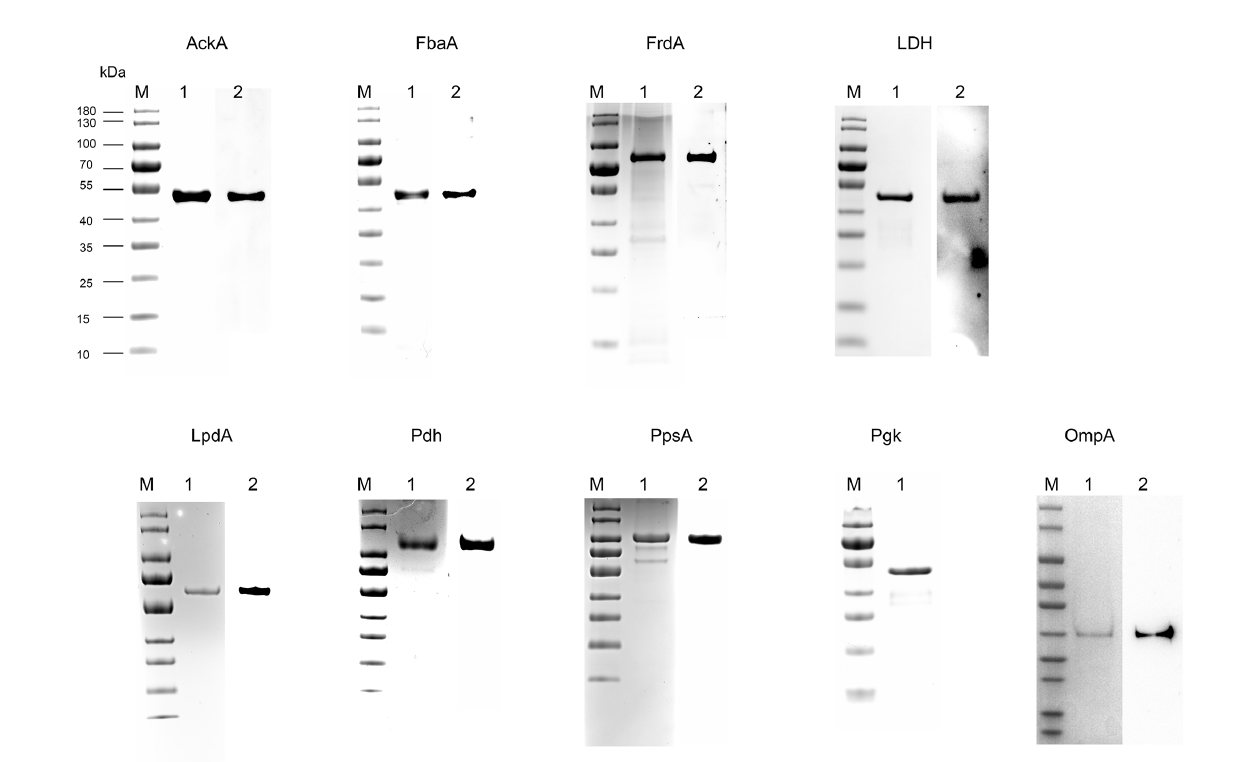
FIGURE 2 | Expression of recombinant proteins and preparation of corresponding antibodies. His-tag recombinant protein AckA, FbaA, FrdA, LDH, LpdA, Pdh, PpsA, Pgk, and OmpA, were analyzed by SDS-PAGE and stained with Coomassie G-250 (lane 1 in each panel). The recombinant proteins (except Pgk) were hybridized to their speci fi c polyclonal antibodies and HRP-conjugated anti-rabbit IgG (lane 2 in each panel).